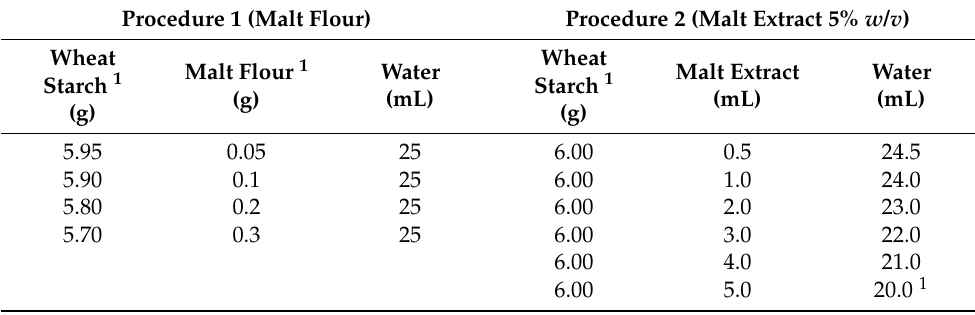
Table 1. Adaptation procedures of the FN